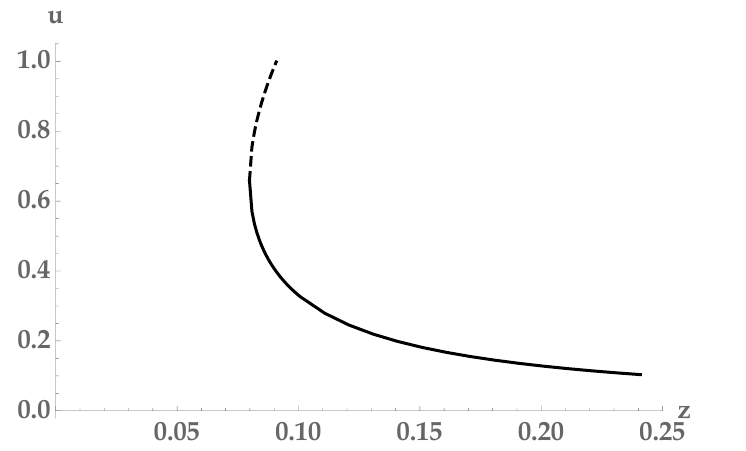
Figure 5 . Solution of the system (C.24) for u as a function of variable z (cid:17) z (cid:8) for N =